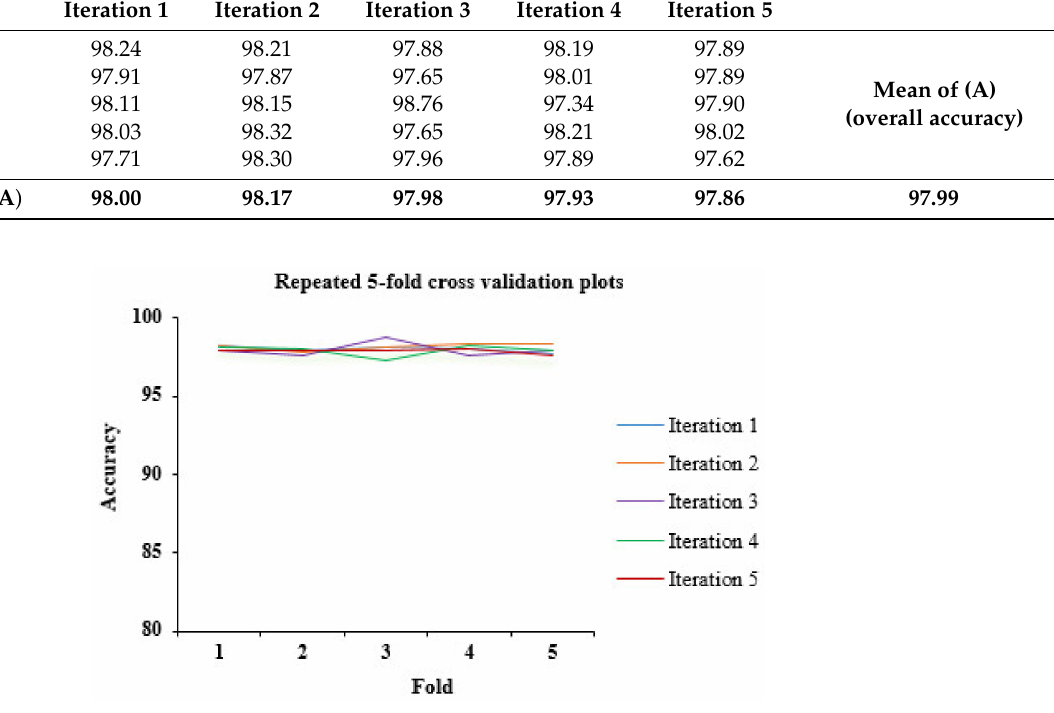
Figure 7. Accuracy plot of repeated K-fold cross validation (K =